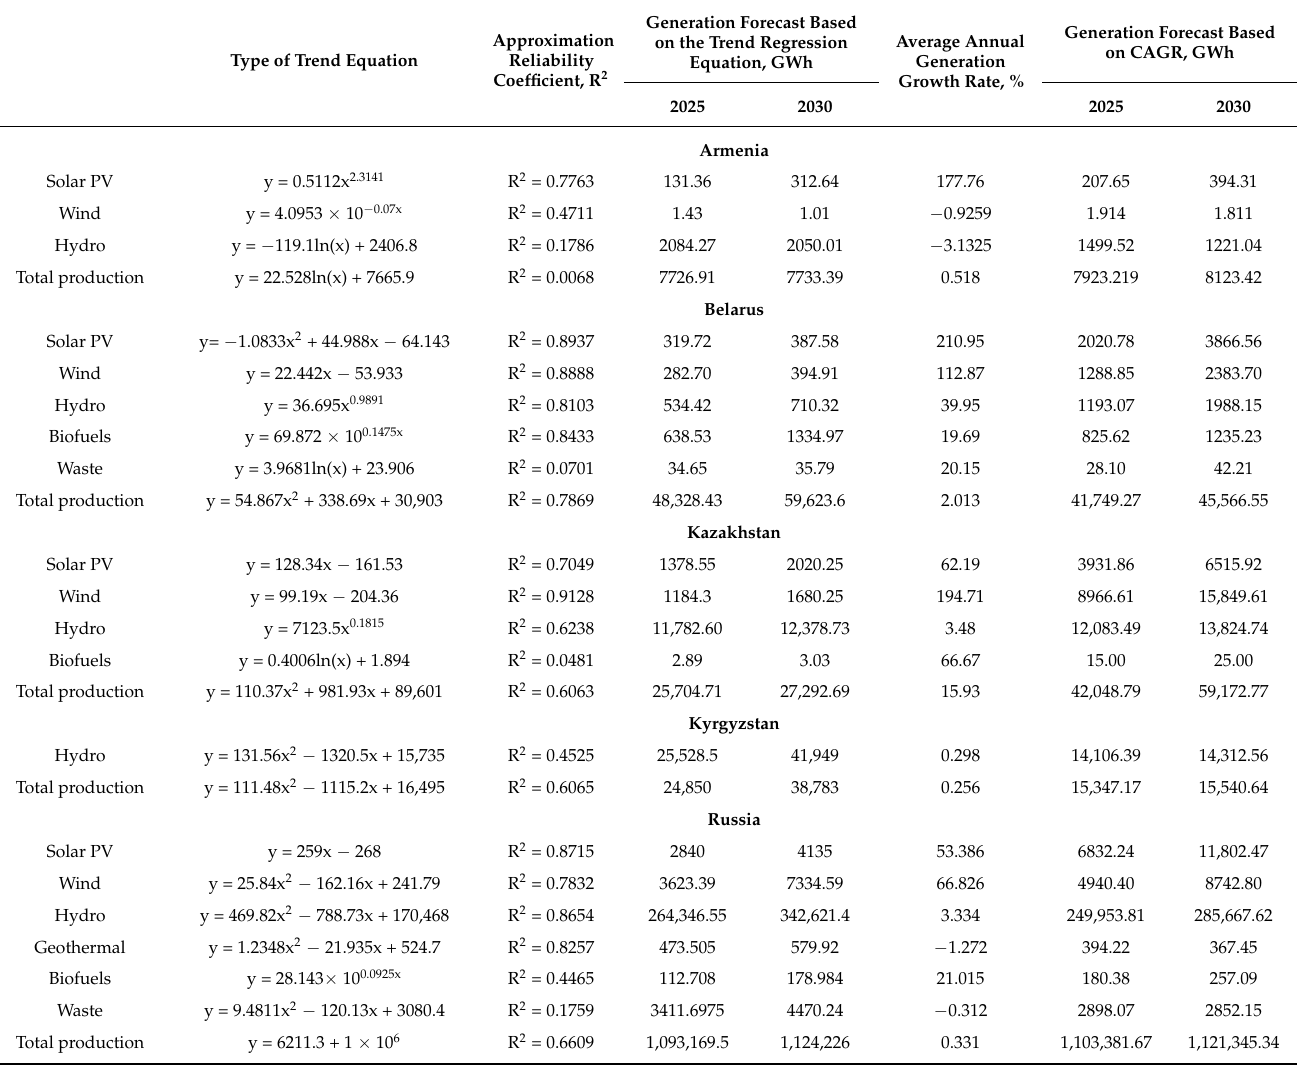
Table 8. Forecast of energy generation for 2025 and 2030 based on calculated data.